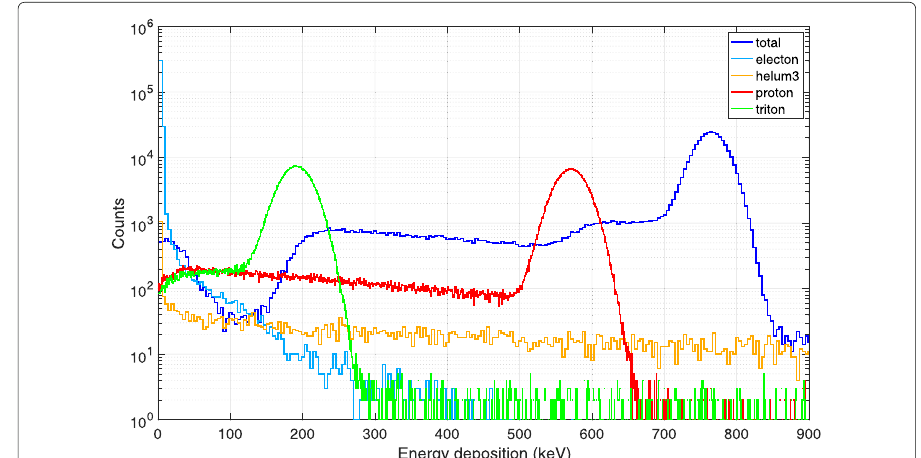
Fig. 5 Simulated energy deposition for the reaction products in configuration